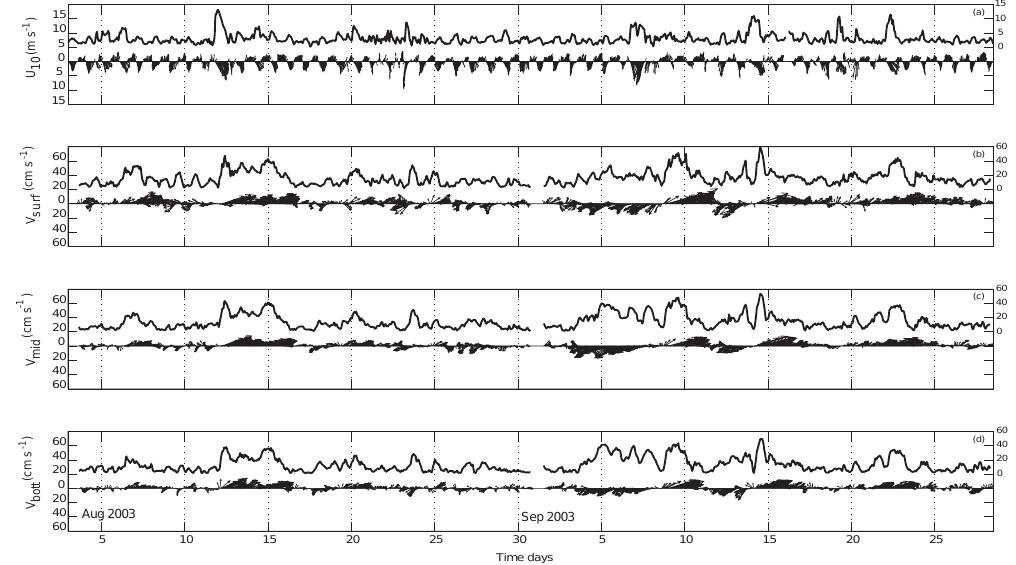
Fig. 4. Current field time series in three different layers respect to the wind. (a) wind speed ( U 10 ); (b) current velocity at surface layer ( V surf ); (c) current velocity at middle layer ( V mid ); (d) current velocity at seabed ( V bott ).